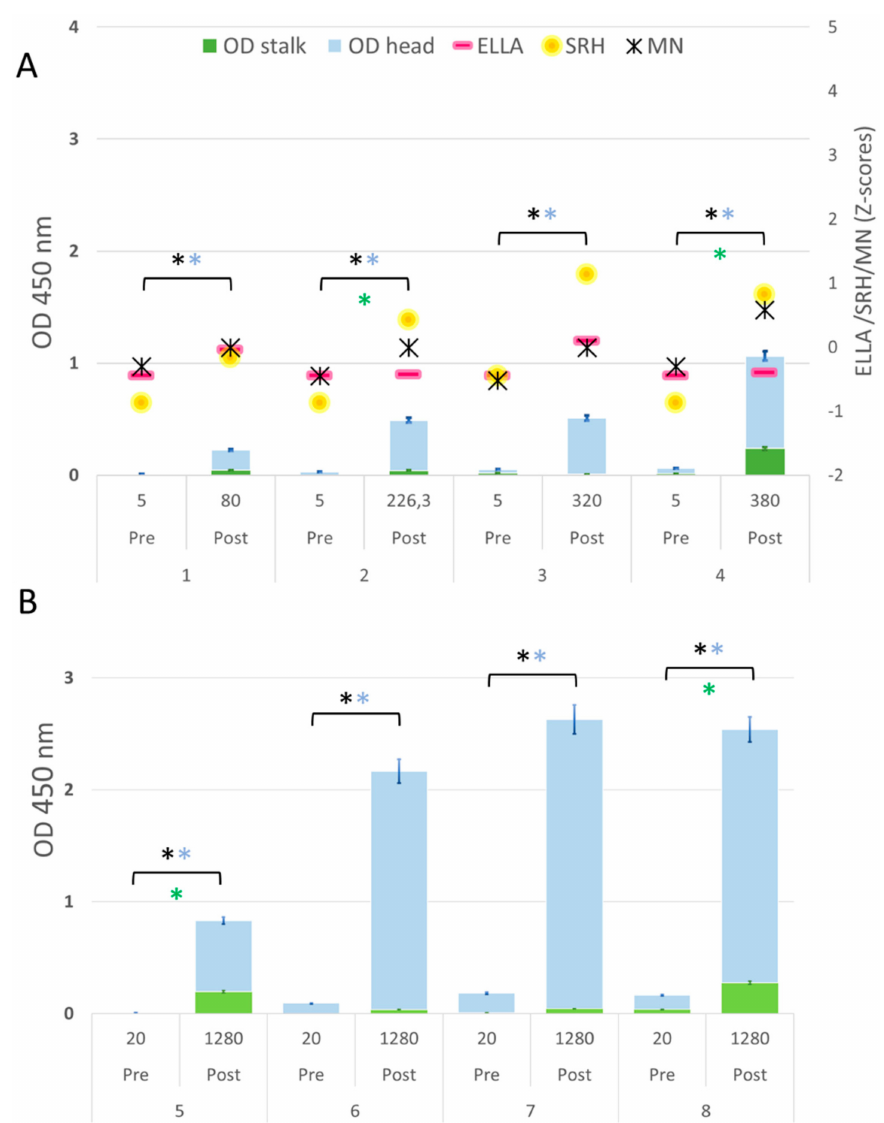
Figure 3. ( A ) Serum samples from children tested by ELISA, HI, SRH, MN and ELLA assays; ( B ) Serum samples from children tested by ELISA and HI. The HI titer of each sample is indicated below the x-axis. Blue bars = head signal, and green bars = stalk signal. Asterisks indicate statistical significance; a black asterisk indicates a significant increase in the HA signal; a blue asterisk indicates a significant increase in the head signal; a green asterisk indicates a significant increase in the stalk signal. Error standard bars are reported both for head and stalk